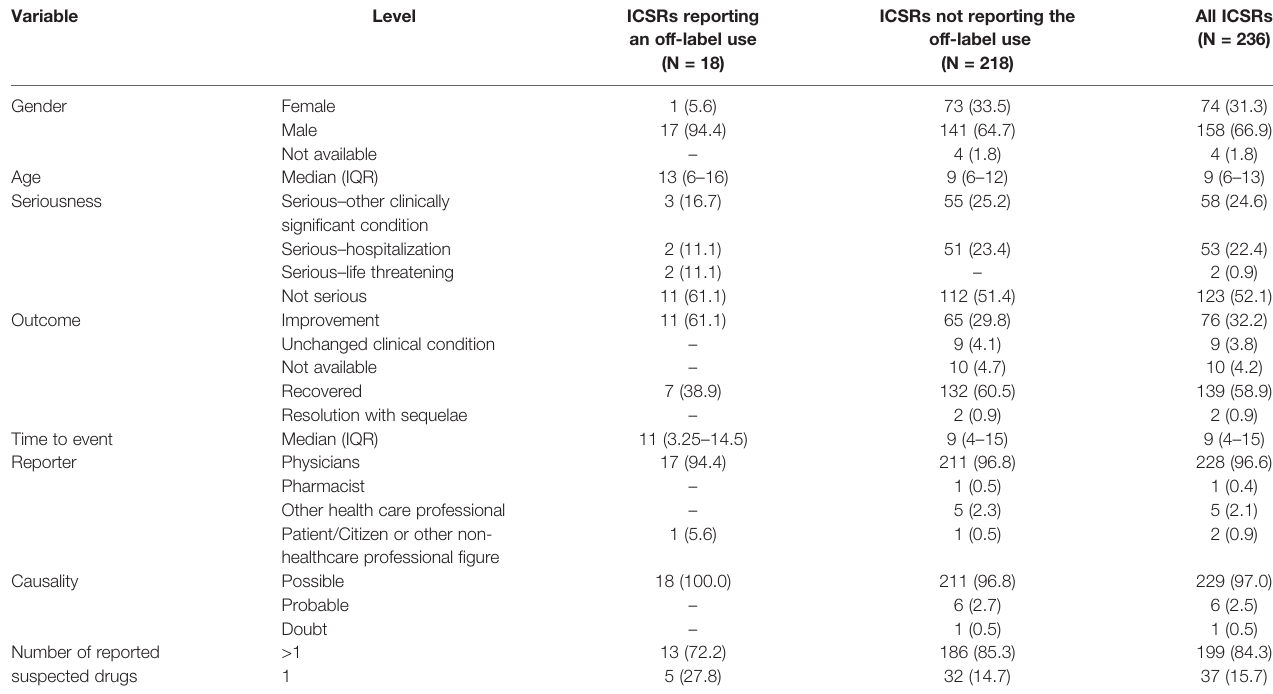
TABLE 1 | Demographic characteristics and distribution for the type of reporter, seriousness and outcome of adverse drug reactions, causality assessment, and number of the reported suspected drugs of all pediatric ICSRs and those reporting or not reporting an off-label use that involve antineoplastic drugs as suspected drugs among those recognized in the Campania spontaneous reporting system from January 2013 to September